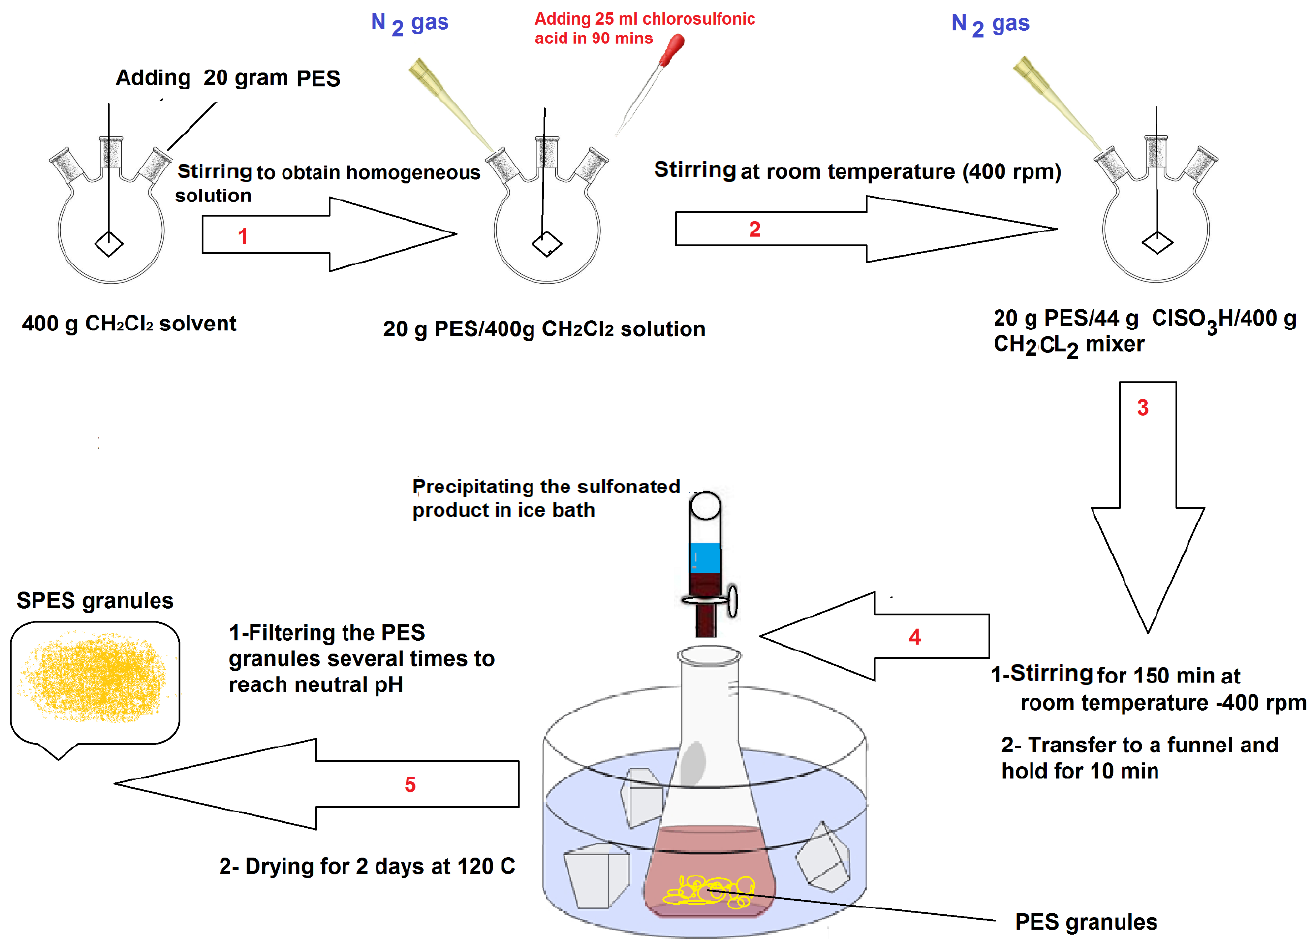
Figure 2. PES sulfonation based on the process by Li et al. [38] .